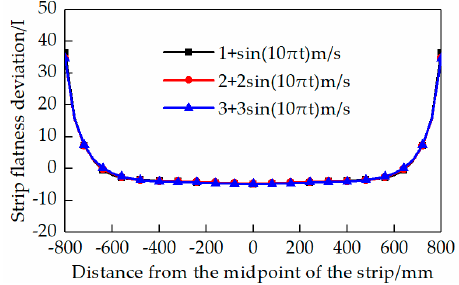
Figure 9. The effect of airflow excitation speed on the flatness calculation deviation. Figure 9. The e ff ect of airflow excitation speed on the flatness calculation